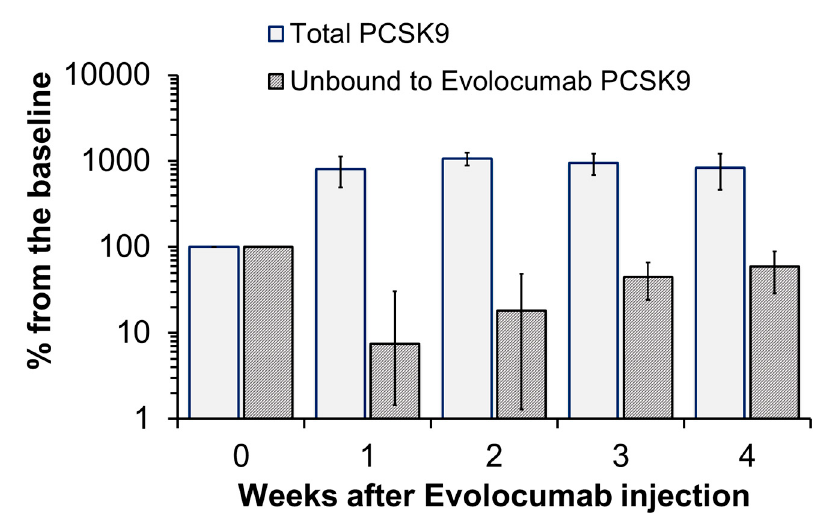
Figure 3. Changes in the concentrations of total PCSK9 and PCSK9 that is not associated with Evolocumab (% of the initial concentration taken as 100%).